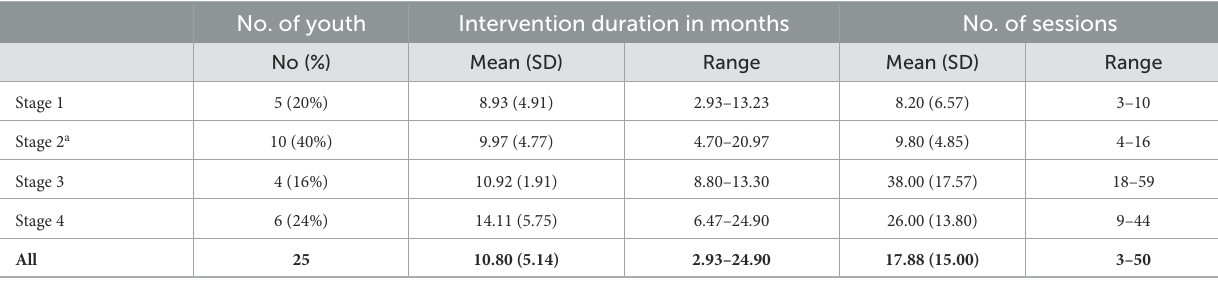
TABLE 1 Case characteristics ( n = 25).